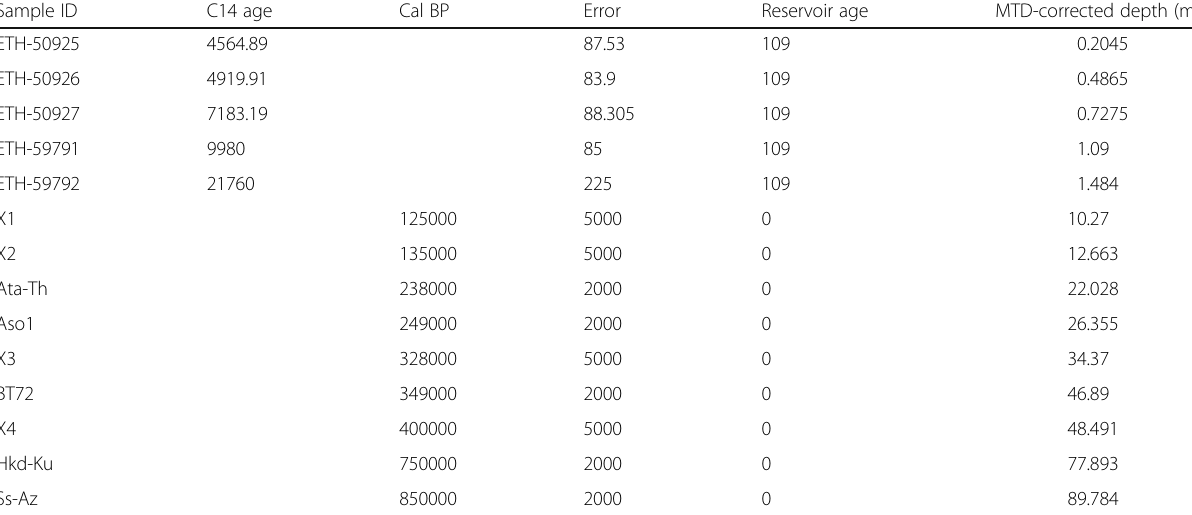
Table 4 Summary of input data for the age – depth model shown in Fig.